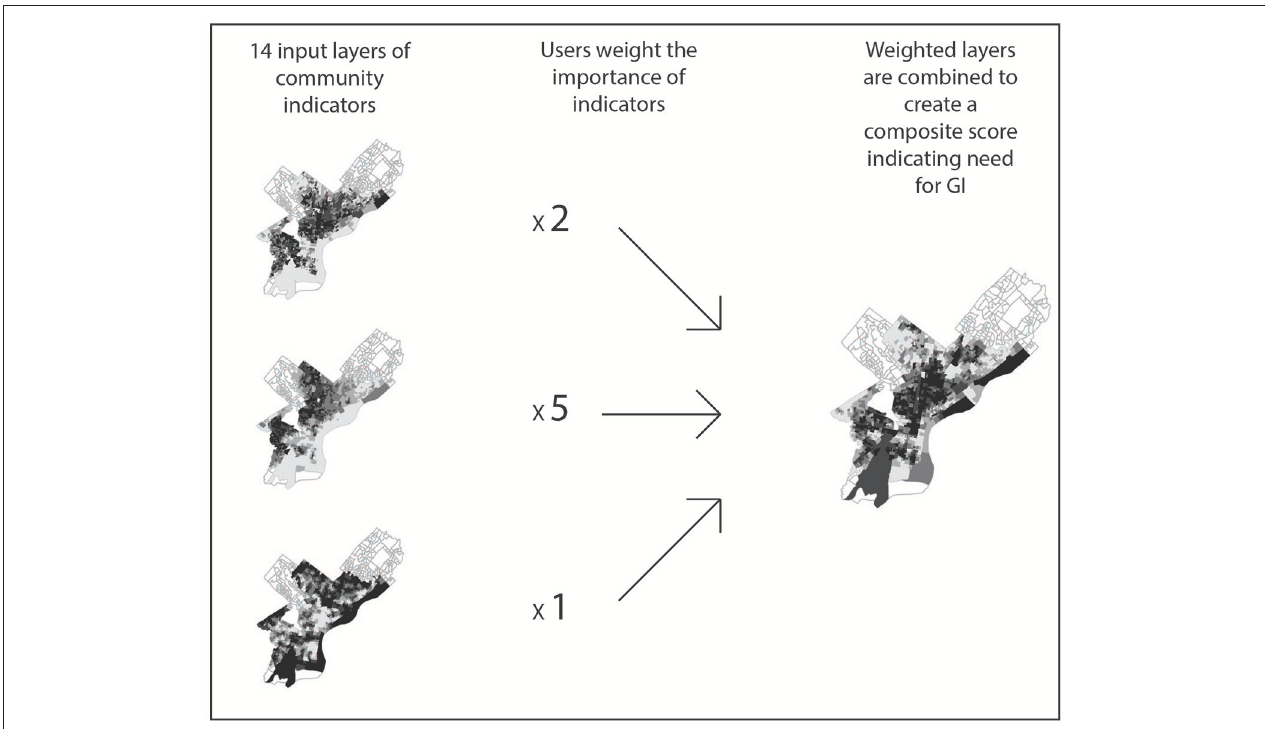
FIGURE 1 | Schematic of the Equity Index in its current form. The original fourteen indicators included: 1) impervious surfaces; 2) particulate matter; 3) traffic; 4) ozone; 5) playground density; 6) parks access; 7) tree canopy cover; 8) percent non-white; 9) percent low-income; 10) percent low educational attainment; 11) percent under 5; 12) percent over 64; 13) percent owner-occupied housing; and 14) vacant land density. The framework is flexible, allowing for different indicators to be used as desired.